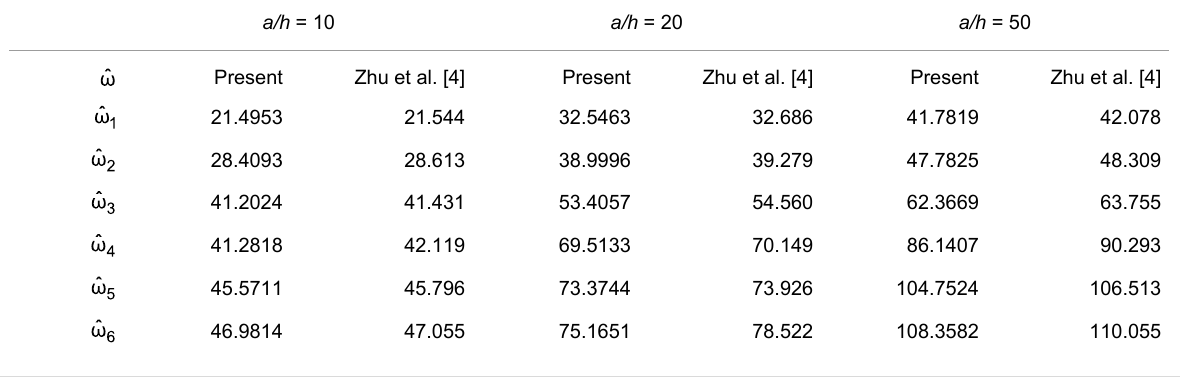
Table 5: First six natural frequencies